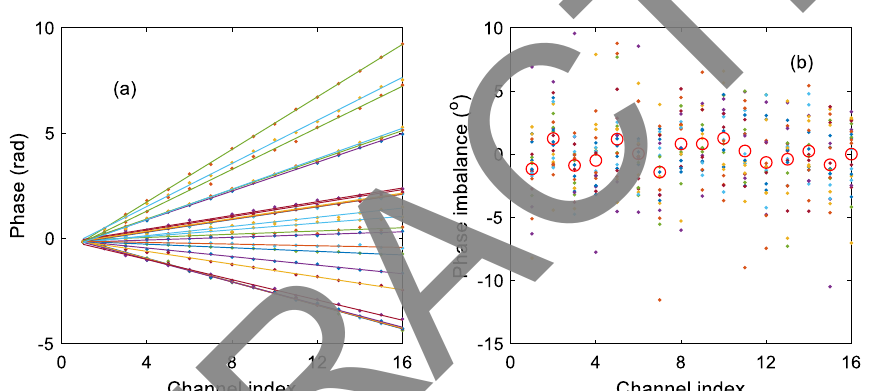
Figure 9. Phases of the echoes from meteor trails received by 16 receivers after correction. (a) The unwrapped phases of the 16 channels after correction and the re- fi tted straight lines. The dots with different colors denote different sets of phases after correction of the 16 channels. The lines with different colors represent different re- fi tted straight lines. (b) The phase deviation from the re- fi tted lines. The dots with different colors denote the deviation between corrected phases from different meteors and the re- fi tted phases. The means of the deviations after correction are presented as red circles. Comparing to Figure 8, the means after correction are reduced signi fi cantly to ±1 (cid:3) , with the same STD.